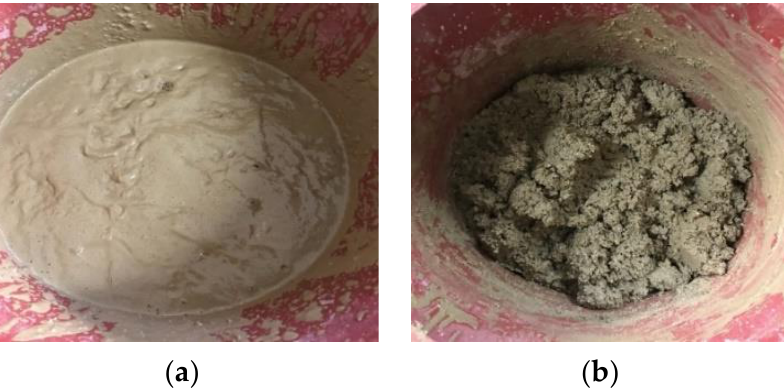
Figure 6. Permeability coefficient changes of conditioned soils with elapse of time (Soil 2–4).